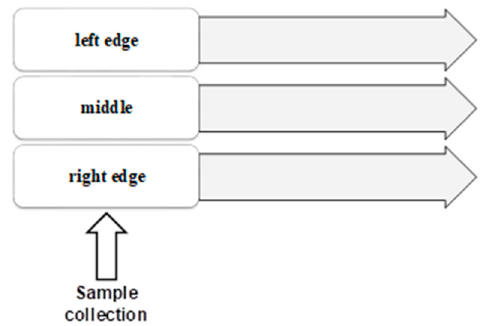
Figure 1. Sample collection points from the baking oven.